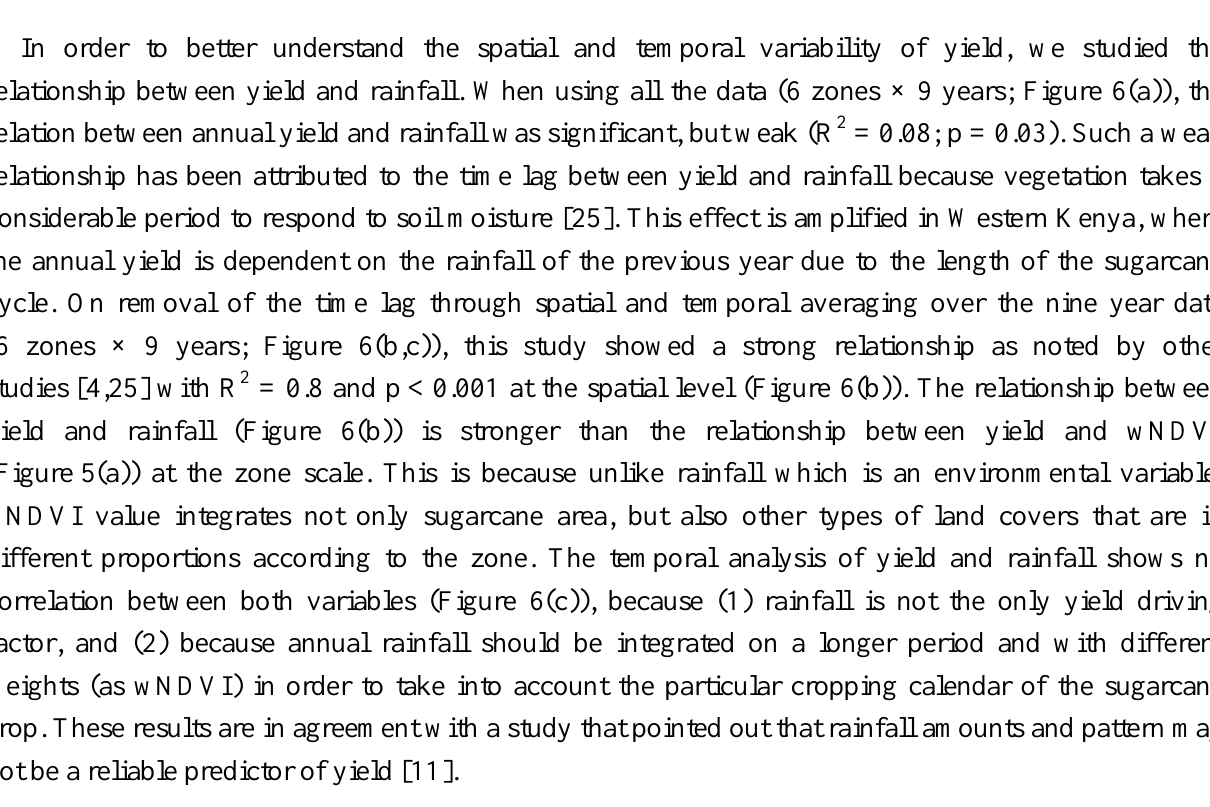
Figure 6. Relationship between yield and rainfall using: ( a ) all the data, ( b ) the data aggregated at the zone scale (spatial analysis), and ( c ) the data aggregated at annual scale (temporal